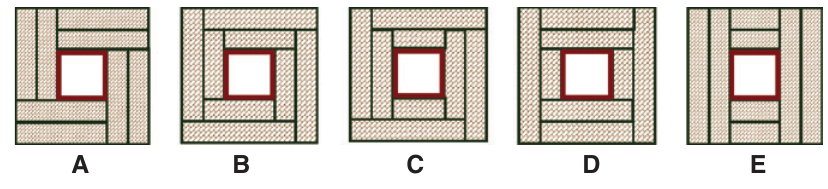
Figure 4: Design of the composite cross section of SBCCs.